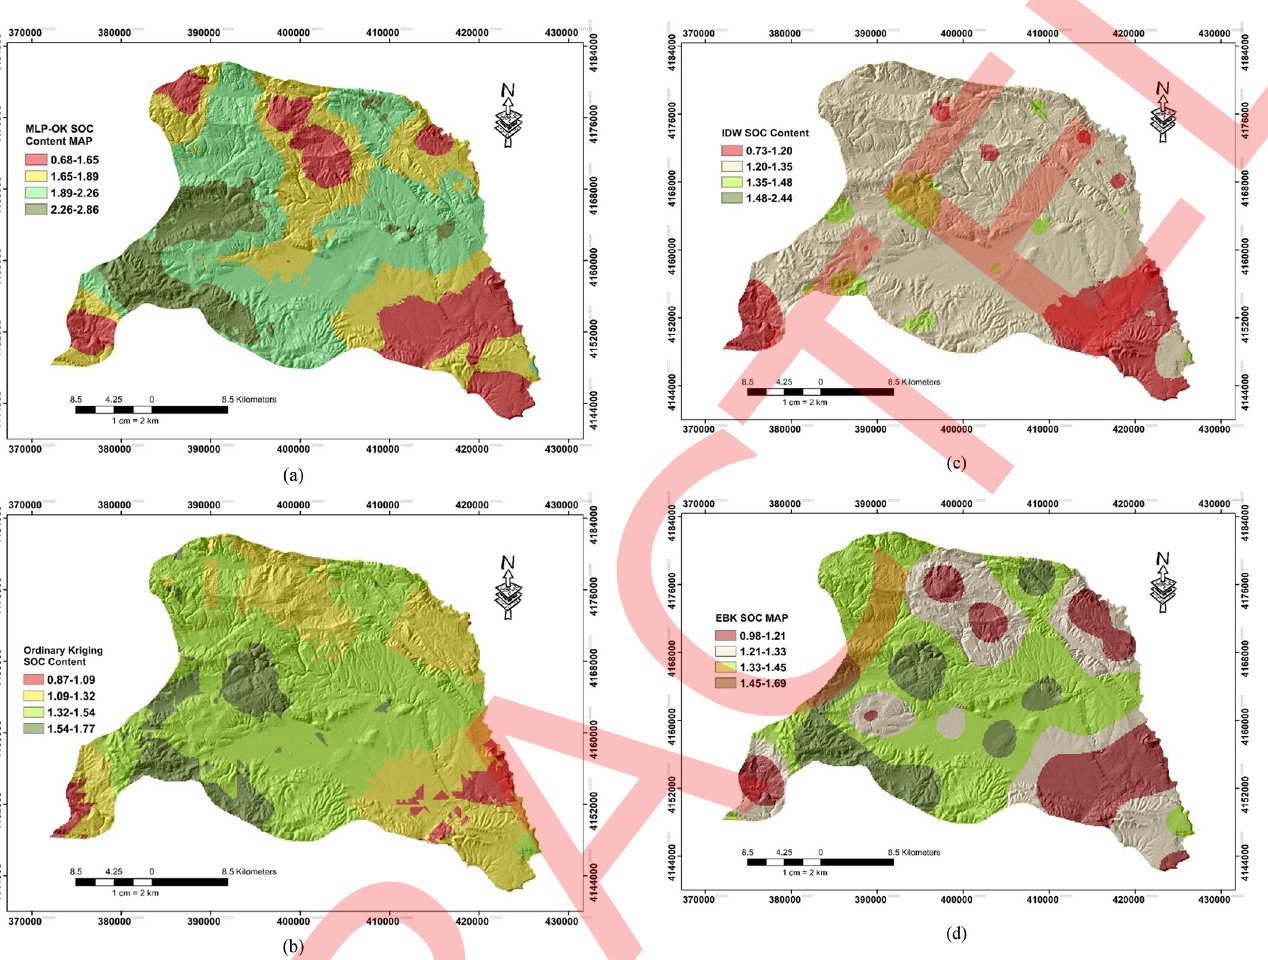
Fig 4. Soil organic carbon (SOC) content maps obtained using different interpolation methods (4a, 4b, 4c, and 4d are the predicted SOC maps for MLP-OK, OK, IDW, and EBK, respectively.).